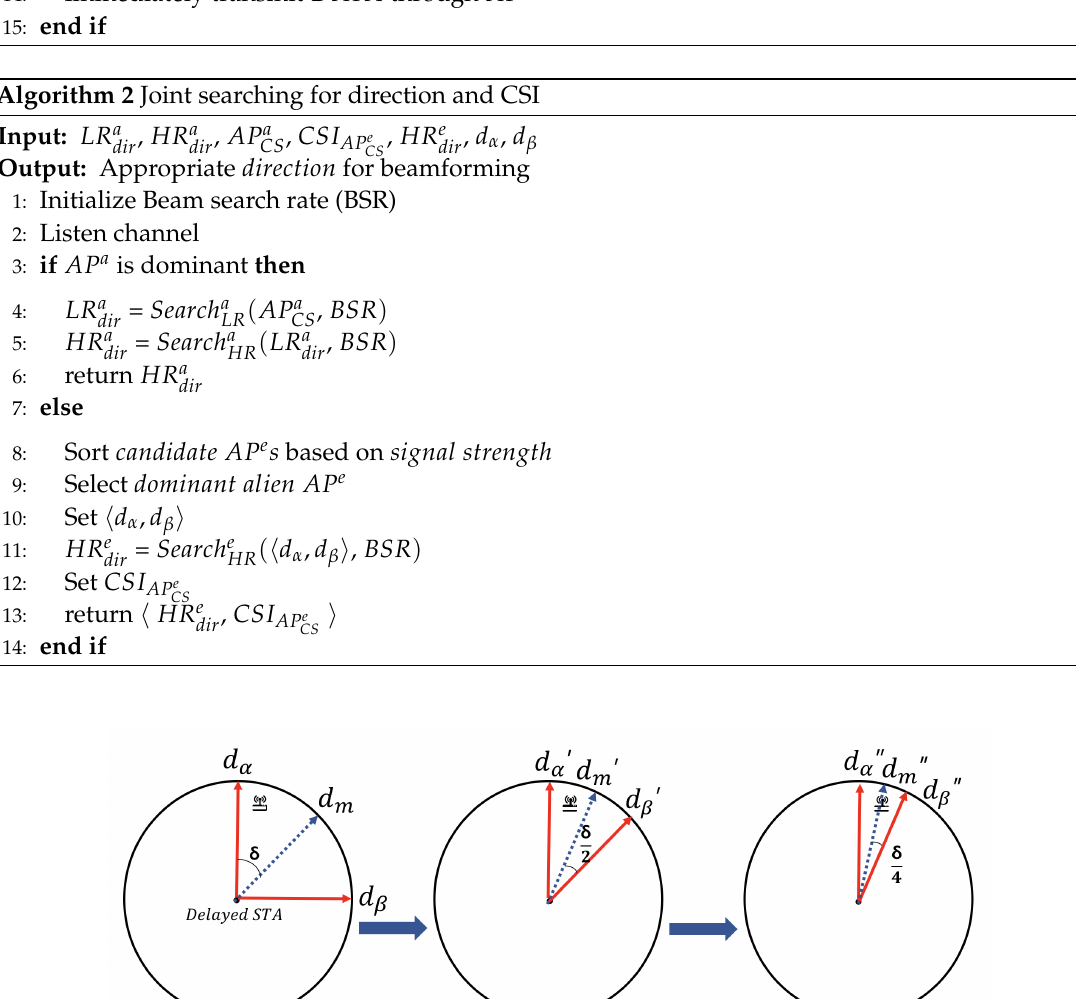
Figure 6. Detailed mechanism of Search e